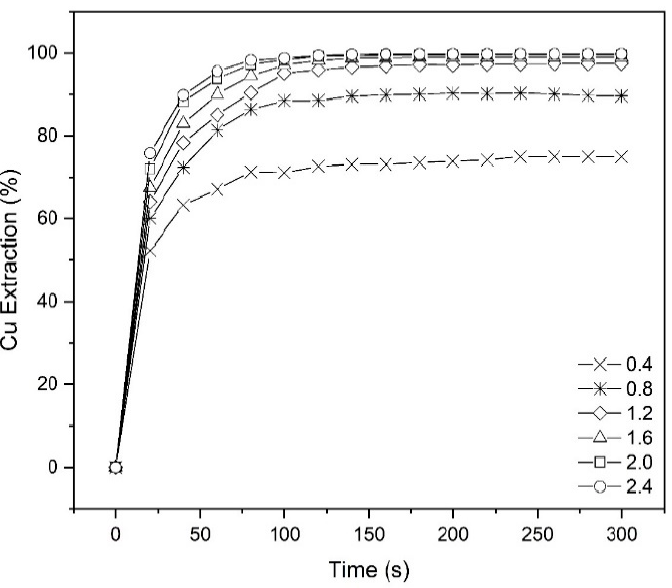
Figure 4. The effect of contact time on copper extraction percentage at different pHs (Mextral 5640H = 10% ( v / v ), O/A = 1, T= 25 °